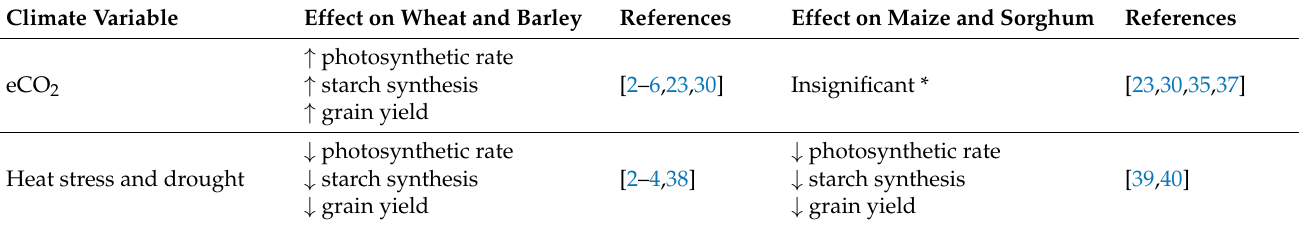
Table 1. Effects of eCO 2 , heat stress and drought on quantity in C 3 cereal grains wheat and barley and C 4 cereal grains maize and sorghum. Upwards arrows indicate an increase and downwards arrows indicate a decrease in the corresponding variable.